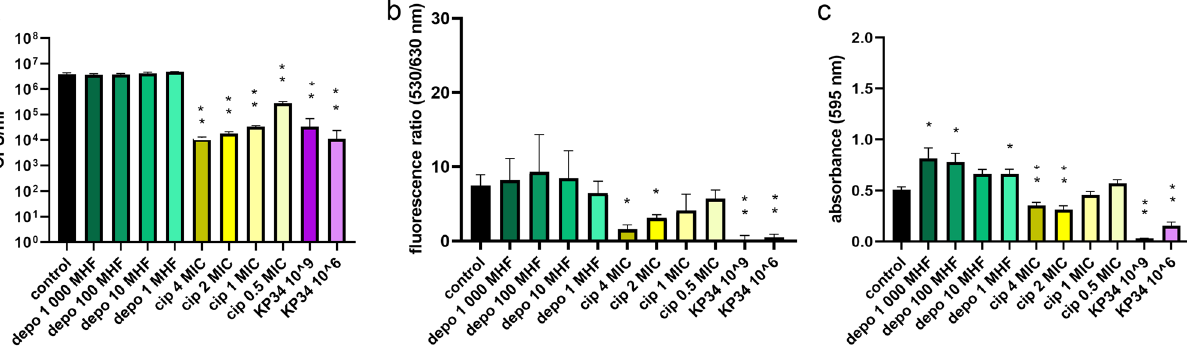
Figure 1. The influence of depolymerase, ciprofloxacin, and infective phage KP34 on K. pneumoniae 77 biofilm formed for 24 h on polystyrene pegs. One-day biofilm was treated for 2 h with: recombinant depolymerase KP34p57 originated from phage KP34 marked as depo, at concentrations corresponding to 1000 MHF (minimal halo forming concentration), 100 MHF, 10 MHF, and 1 MHF, green bars; ciprofloxacin marked as cip, at concentrations corresponding to 4 MIC (minimal inhibitory concentration), 2 MIC, 1 MIC, and 0.5 MIC, yellow bars; and lytic phage KP34 marked as KP34 (10 9 PFU/ml and 10 6 PFU/ml, violet bars). Biofilm eradication was examined with three different microtiter methods: ( a ) the colony count (CFU/ml); ( b ) LIVE/DEAD BacLight Bacterial Viability Kit with live to dead cells ratio at fluorescence 530/630 nm; ( c ) the crystal violet staining